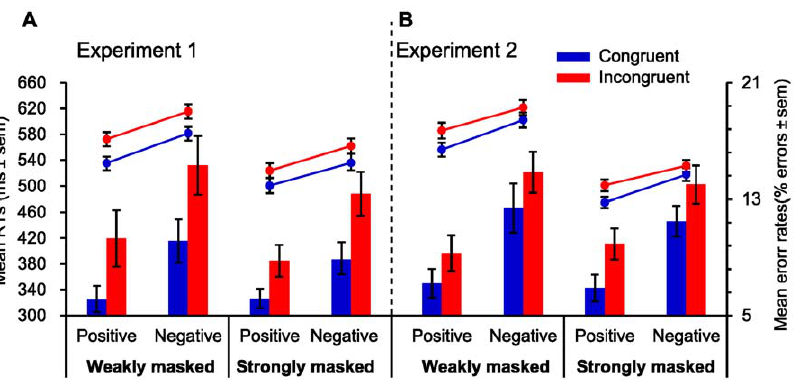
Figure 2. Mean RTs for correct trials and mean error rates as a function of target valence and valence congruency in weakly masked and in strongly masked groups. (A) Emotional conflict results in Experiment 1. (B) Emotional conflict results in Experiment 2. Emotional conflict effects were significant on mean RTs and error rates for positive and negative conditions in the weakly masked and strongly masked groups. Points in the line chart represent the mean RTs in each experimental condition. Bar graphs represent the mean error rates in each experimental condition. Error bars depict standard errors of the means (SEM).